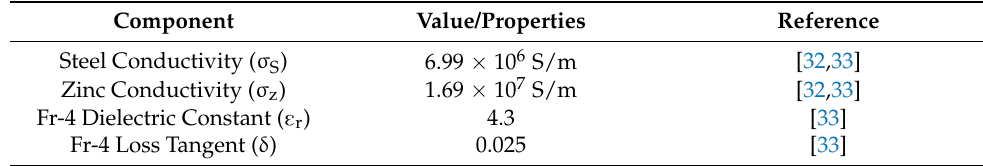
Table 2. Simulation material